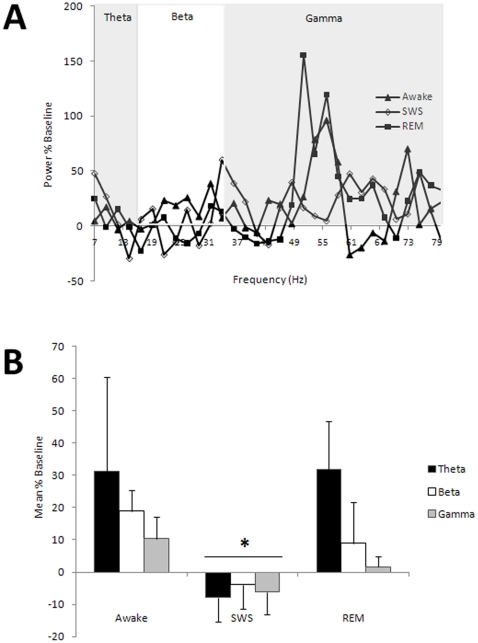
Odor evoked activity in the piriform cortex changes across behavioral states.(A) Representative odor evoked anterior piriform cortex activity during awake, REM, and SWS from one animal. During both awake and REM odor stimulation increased activity in the gamma (35–85 Hz) frequency band. There was no obvious odor-evoked activity in the piriform cortex during SWS. (B) During Awake and REM, there was significantly greater odor evoked activity in all frequency bands (mean odor-evoked activity ± SEM) compared to SWS.